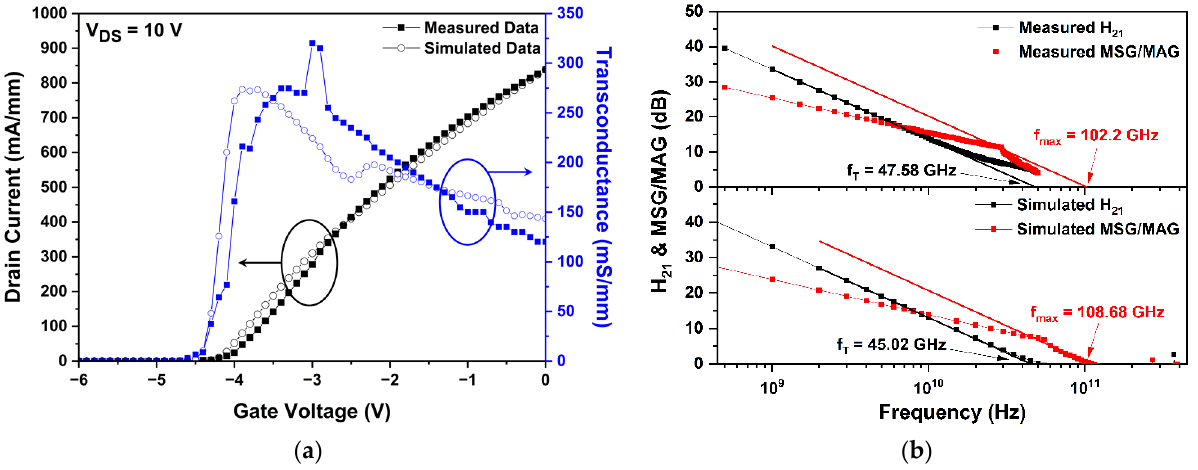
Figure 5. ( a ) Overlay of measured and simulated drain current-gate voltage (I DS -V GS ) transfer characteristics of a basic T-gate HEMT; ( b ) measured and simulated frequency characteristics of a basic T-gate HEMT at drain voltage (V DS ) = 20 V, gate voltage (V GS ) = − 3.2 V.